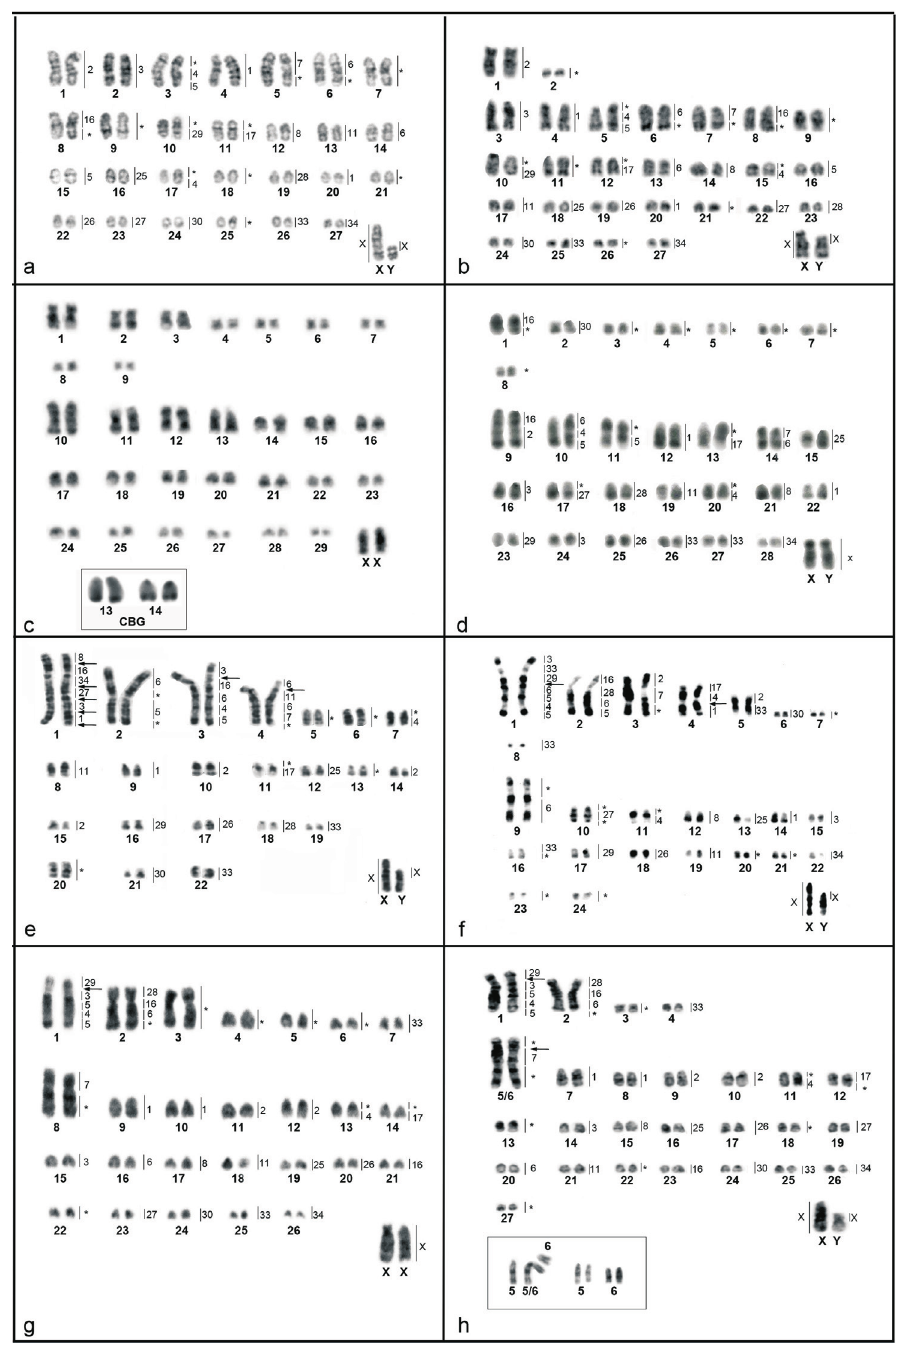
Figure 1 - DAPI or GTG-banding of Cerradomys species: (a) C. marinhus – 2n=56, FN=54; (b) C. maracajuensis – 2n=56, FN=58; (c) C. akroai – 2n=60,FN=76,inset:CBGofpairs13and14;(d) C.scotti –2n=58,FN=72;(e) C.langguthi –2n=46,FN=56;(f) C.vivoi –2n=50,FN=64;(g) C.goytaca – 2n=54, FN=66 and (h) C. subflavus – 2n=54, FN=62; inset: pairs 5 and 6 involved in centric fusion in specimens with 2n=55 and 2n=56, respectively. Except for C. akroai , hybridization pattern of OMO probes are indicated beside the chromosomes. Arrows indicate ITS. *Represent regions not hybrid- ized by any OMO